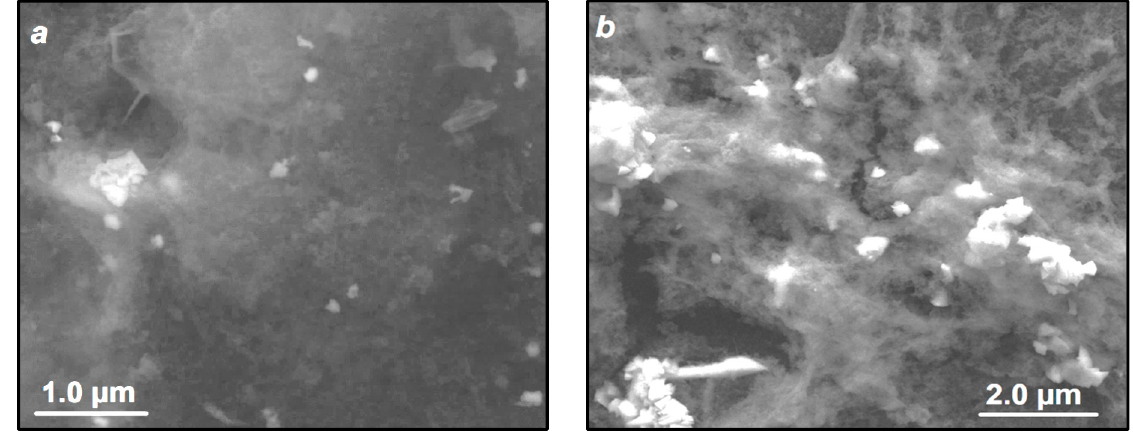
Figure 7. SEM images of the hybrid CuI-PPy structures (sample 4, route 1) obtained from modified SPE/GO ( a ) and